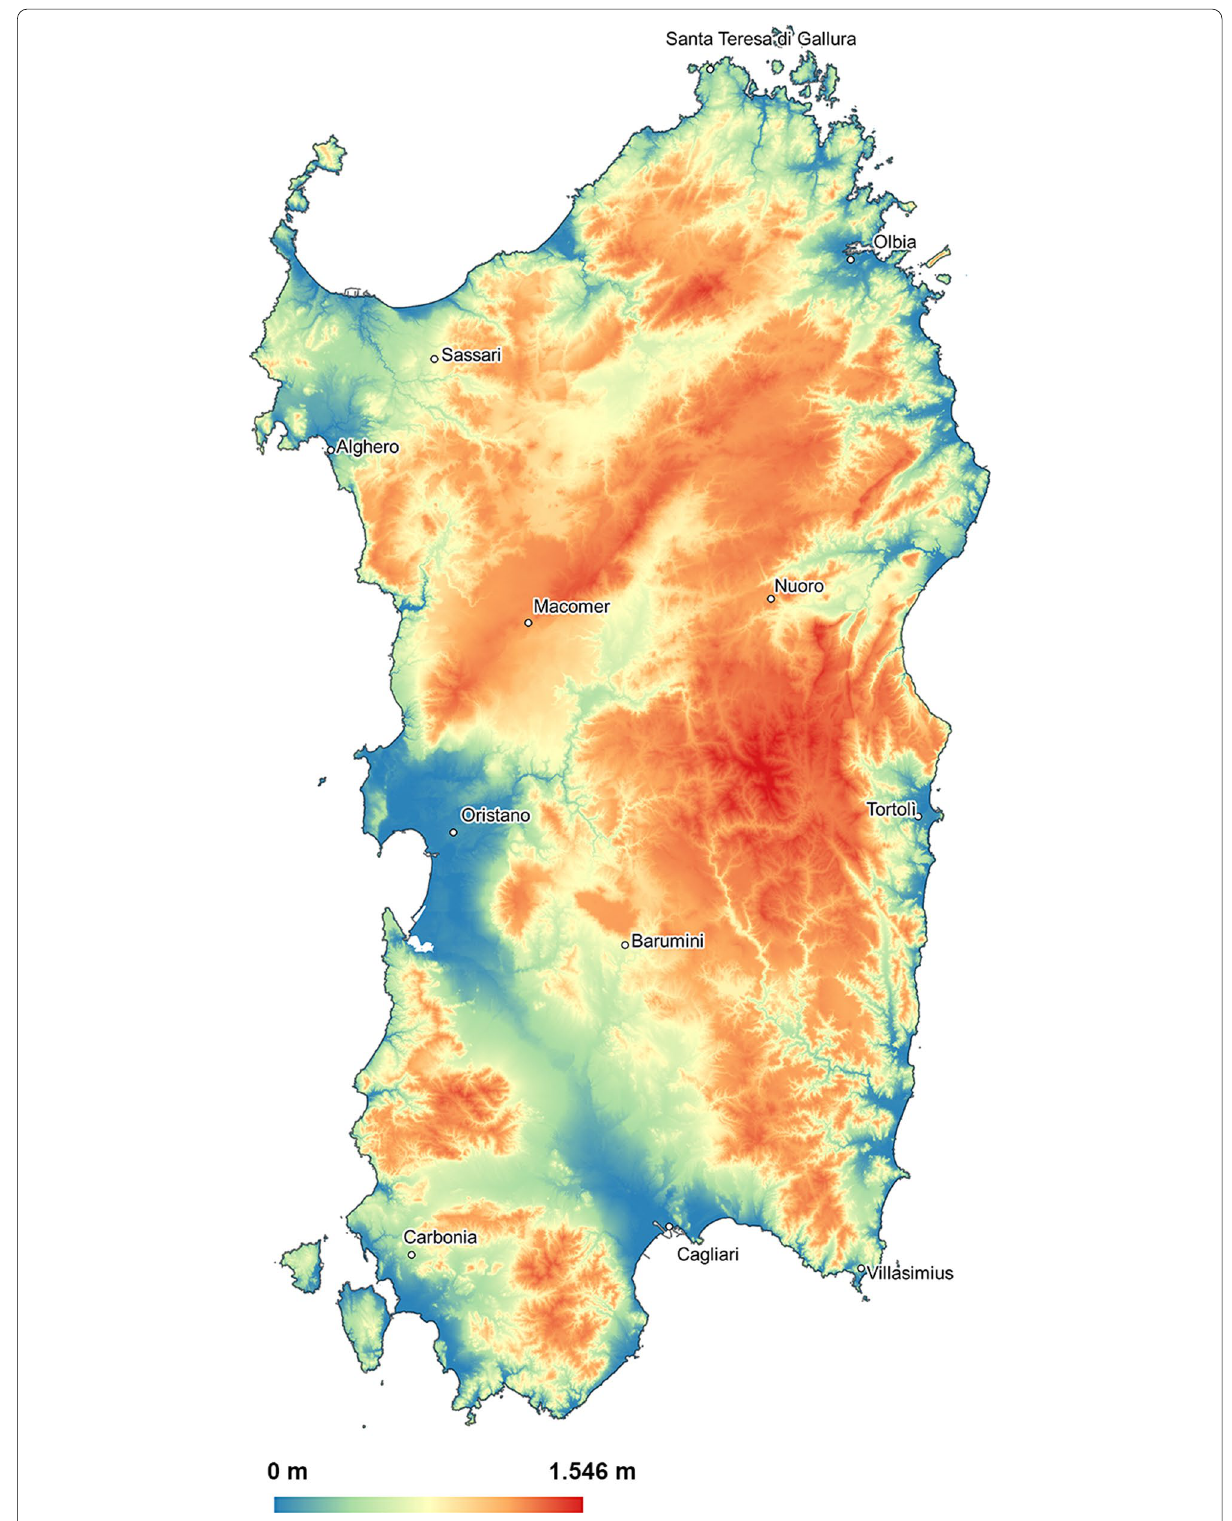
Fig. 7 Geomorphological analysis at the regional